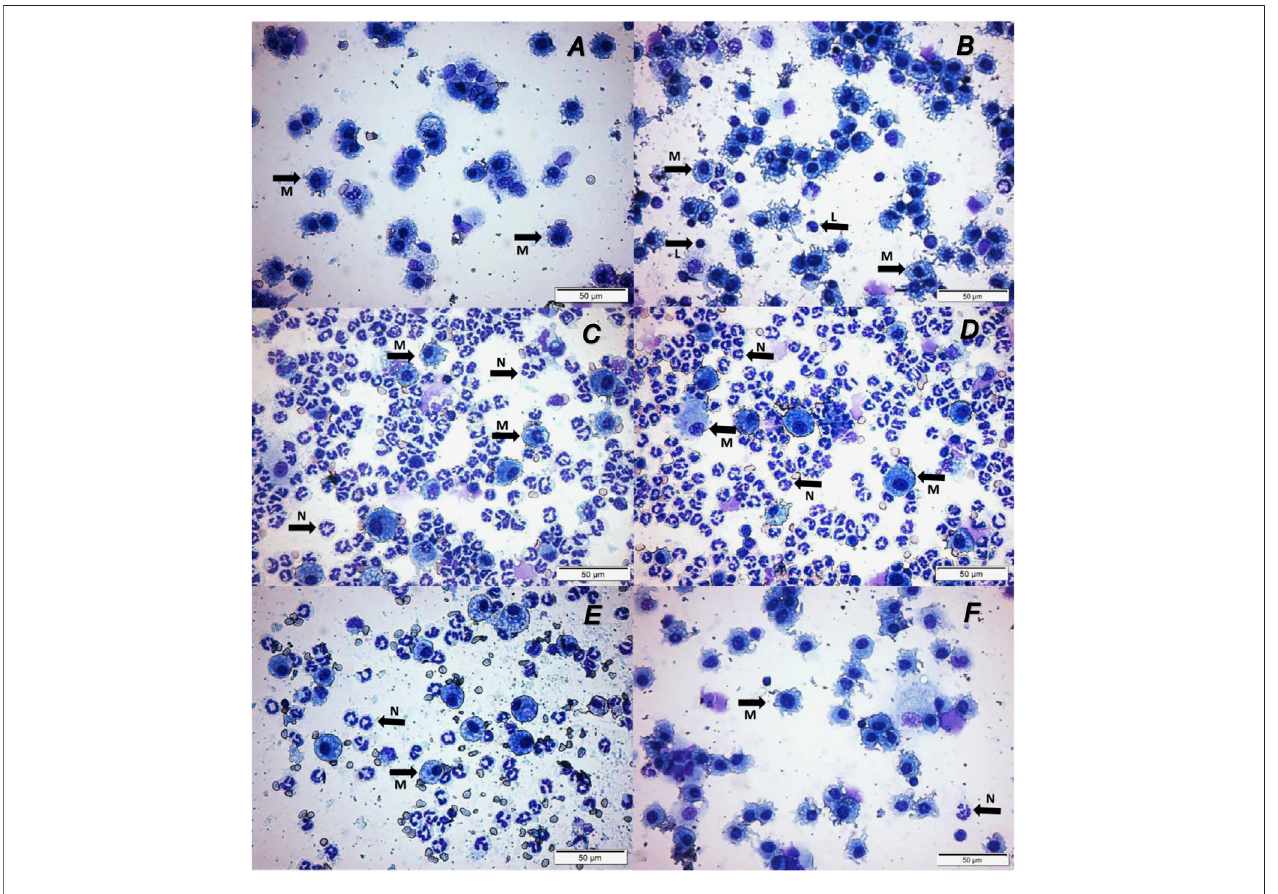
FIGURE4 | Pyridostigmine treatment results inlower levels ofnumbers ofmacrophages, neutrophils, and lymphocytes inBAL ( Representative photomicrographs differential cells in BAL). (A) Control at 24 h, (B) Control at 72 h, (C) LPS + vehicle at 24 h, (D) LPS + vehicle at 72 h, (E) LPS + pyridostigmine at 24 h, and (F) LPS + pyridostigmine at 72 h. The arrows in the images indicate some of the cells with morphology of neutrophils and macrophages (See the text for